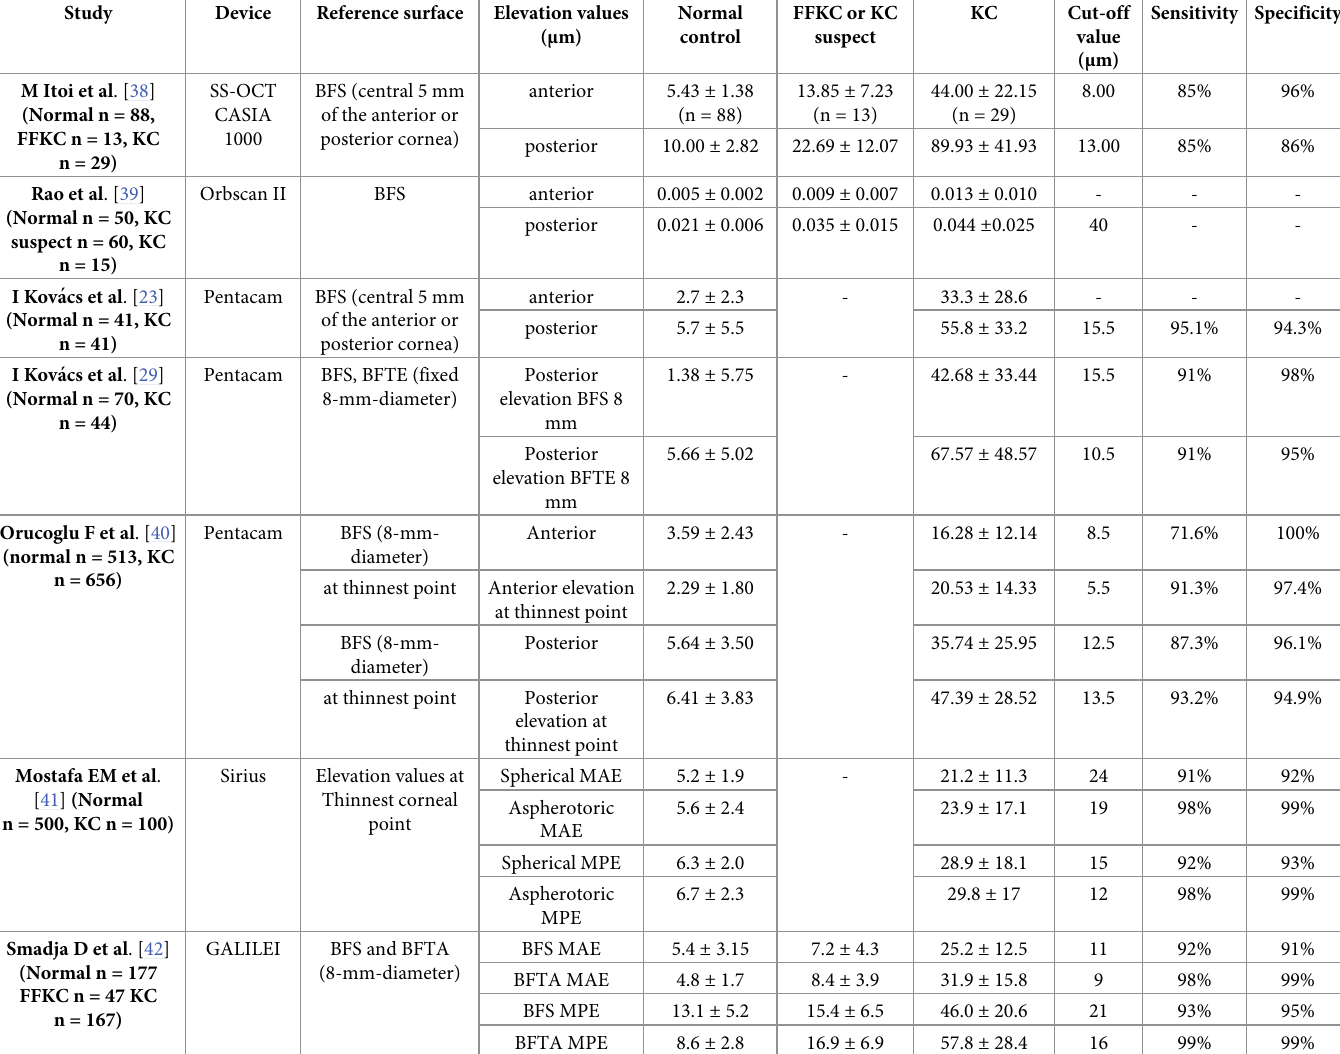
Table 4. Cut-off point, specificity, and sensitivity values identified in previous